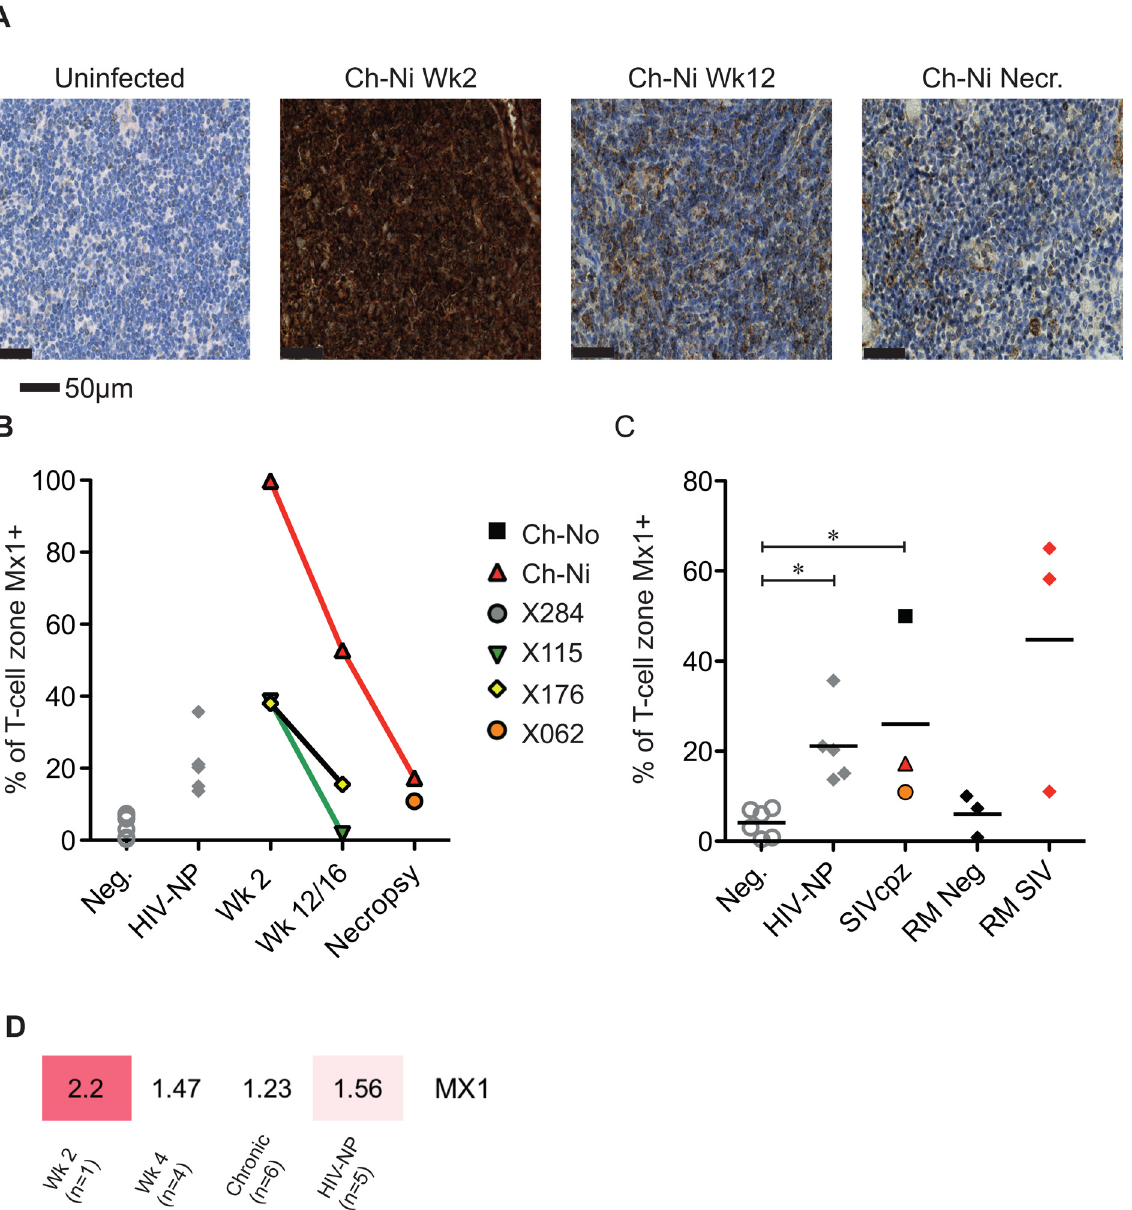
Fig 6. Analysis of Mx1 expression in the lymph nodes of SIVcpz infected chimpanzees. (A) Representative images of anti-Mx1 staining in the T-cell zones of a lymph node of an uninfected chimpanzee, and of Ch-Ni at week 2 and 12 post infection, and at necropsy. (B) Proportion of lymph node T-cell zones staining for anti-Mx1 staining over the course of experimental SIVcpz infection. (C) The same analysis in uninfected chimpanzees (n = 6), chronic HIV- 1 infected (n = 5) chronic SIVcpz infected chimpanzees (n = 3), uninfected rhesus macaques (RM neg, n = 3) and SIVmac infected rhesus macaques (RM SIV, n = 3). Horizontal black bars indicate the mean value in each group. * indicates P < 0.05 in a Kruskal – Wallis test with Dunn ’ s post test. (D) Transcription level expression of Mx1 in PBMCs in the RNA-seq cohort, numbers indicate fold upregulation compared to the control group (n =